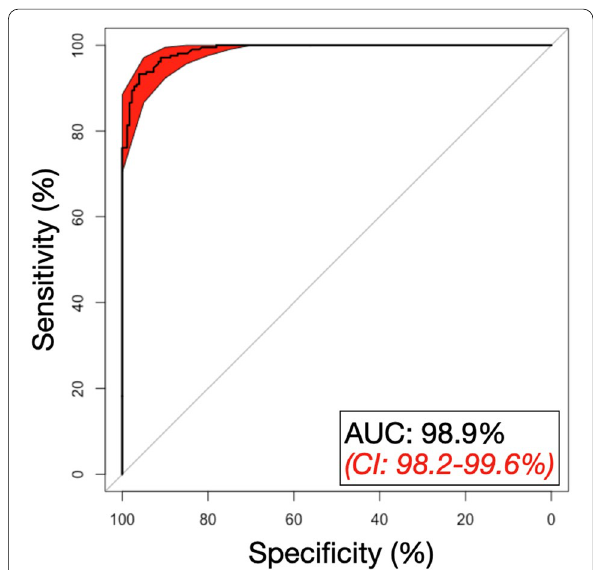
Fig. 2 ROC curves showing the validity of image quality (derived from the CAT12 toolbox) for discriminating passing (versus failing) human rater visual checks of quality. Sensitivity and specificity were both high, suggesting image quality was able to robustly parse this binary categorization. 95% Confidence Intervals of these ROC curves are shown in